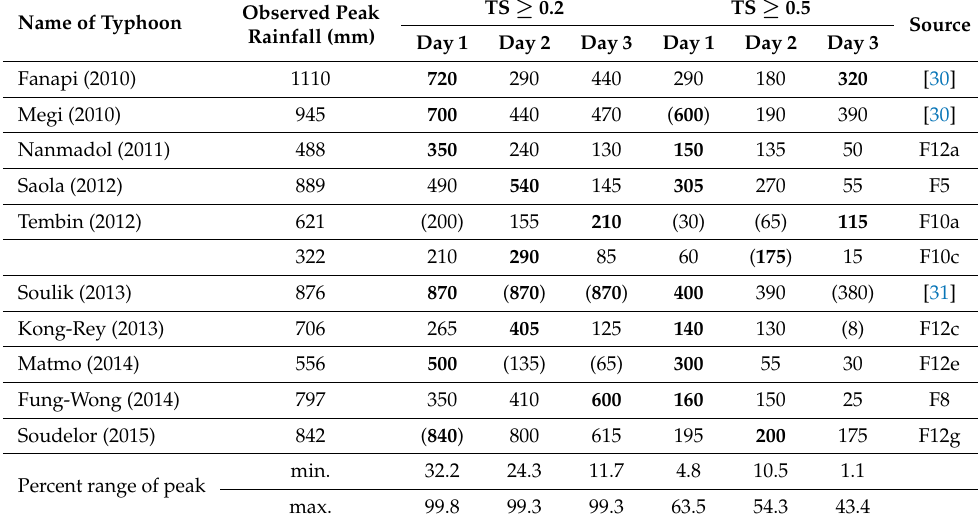
Table 3. Highest rainfall threshold (mm, per 24 h) to reach TS values of 0.2 and 0.5 at the three ranges of day 1 (0–24 h), day 2 (24–48 h), and day 3 (48–72 h), respectively, from the QPFs for the